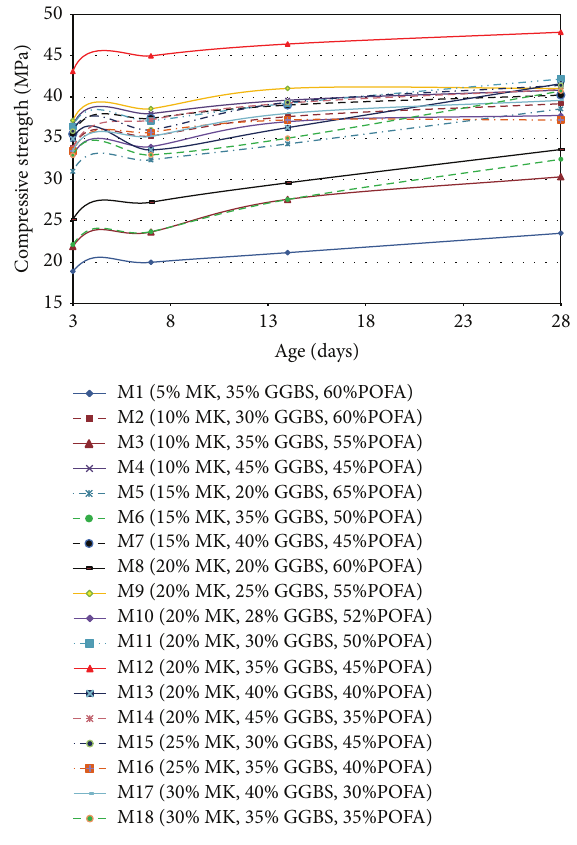
Figure 12: Compressive strength development of mortar at different ages with varying binder content ratios.